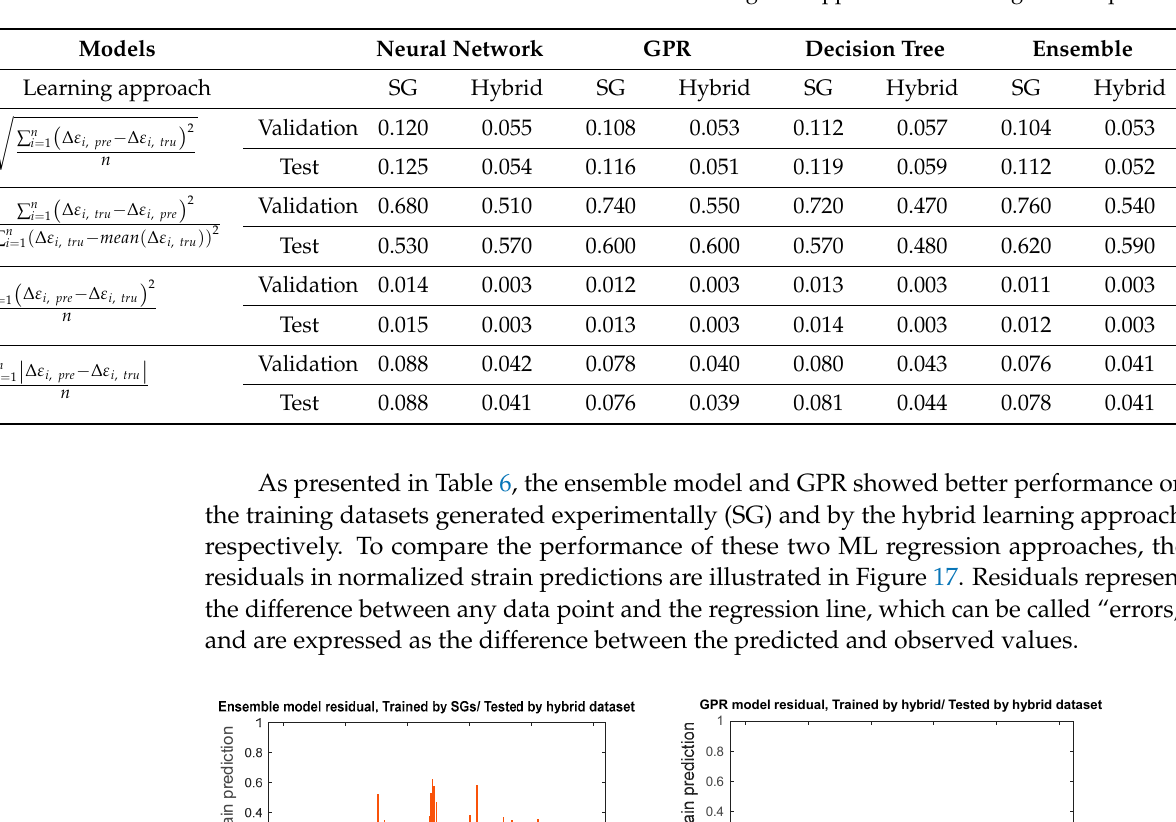
GPR model residual, Trained by hybrid/ Tested by hybrid dataset